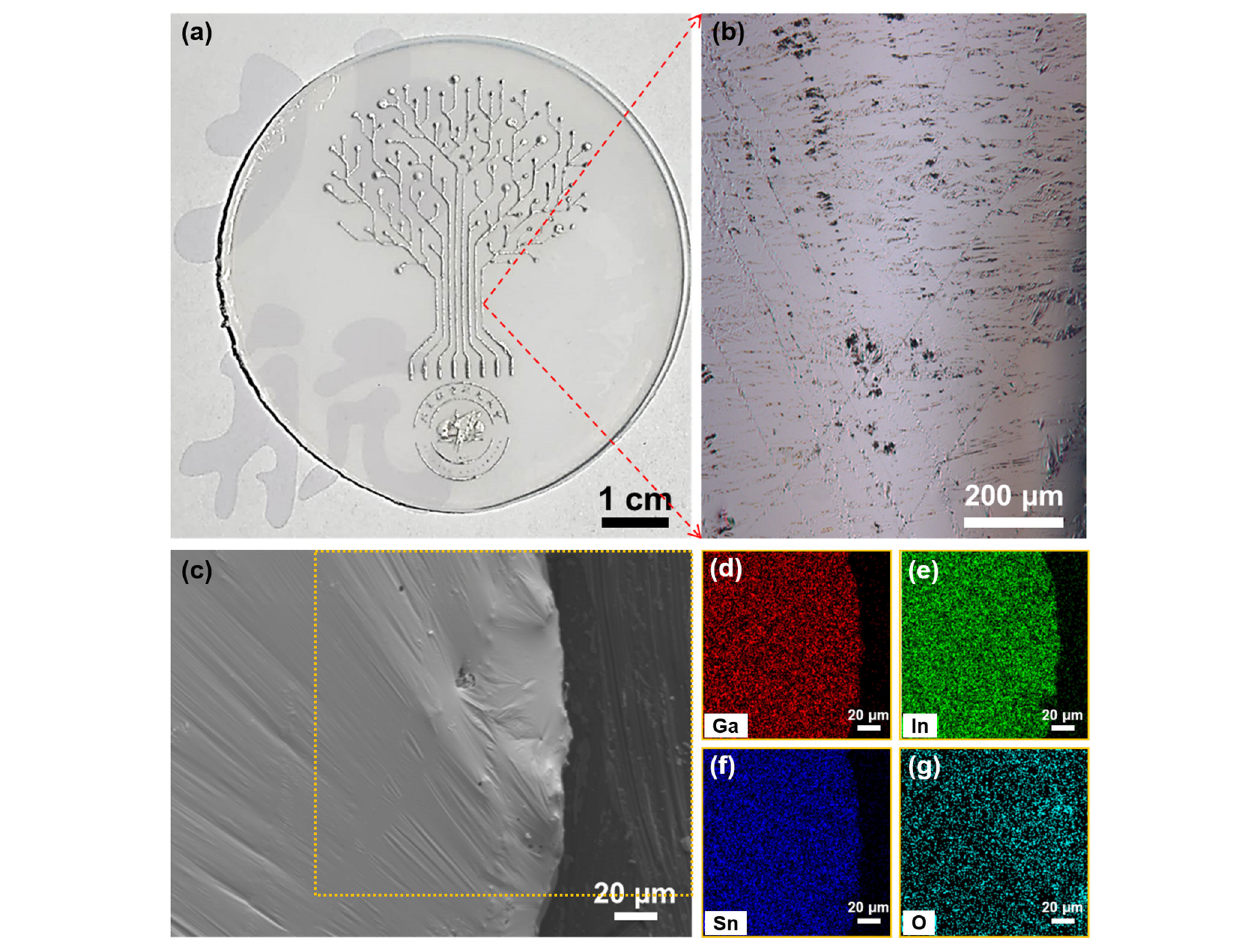
FIGURE 1 | (a) Digital image of a printed galinstan pattern. (b) Optical microscope image of a local area marked in (a) . (c) SEM of the edge area of the printed galinstan pattern in (a) , and (d)–(g) the corresponding EDX mapping results in (c) ; ( (d) for Ga, (e) for In, (f) for Sn, and (g) for O,